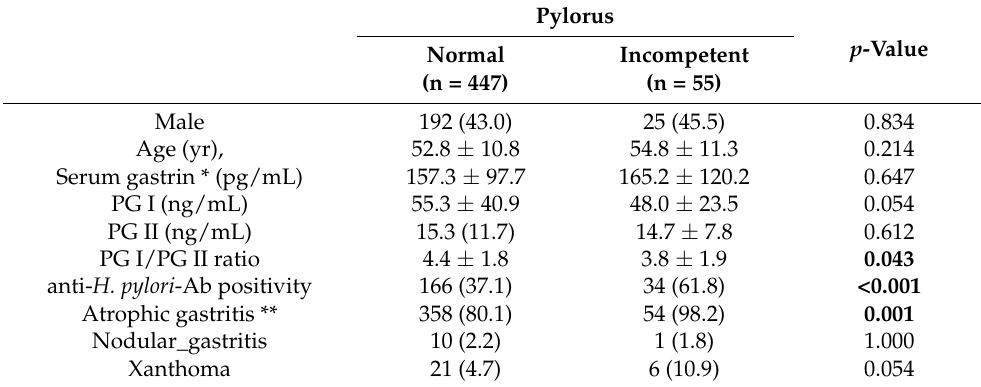
Table 2. Univariate analysis of factors according to the competency of the